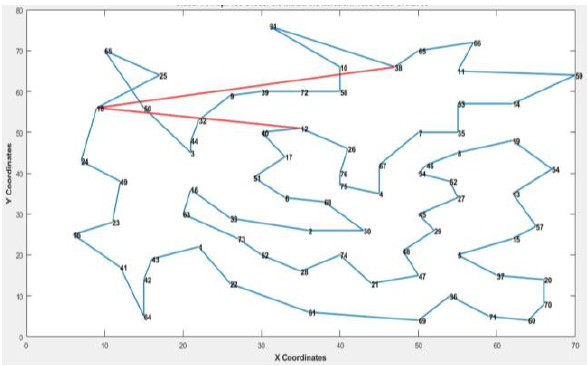
Fig 13. Eil76 path with constraints cities 12,18 and 38